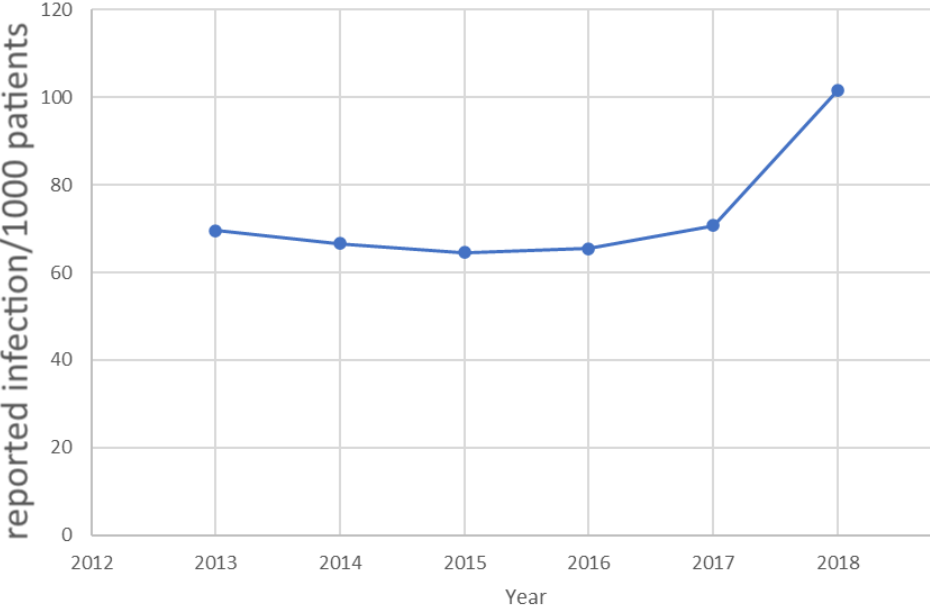
Figure 1. The total number of reported infections in Hungary until the Coronavirus outbreak, when the data reporting scheme was fundamentally changed by the authorities. (Source: OEK 2019, [13] ) .